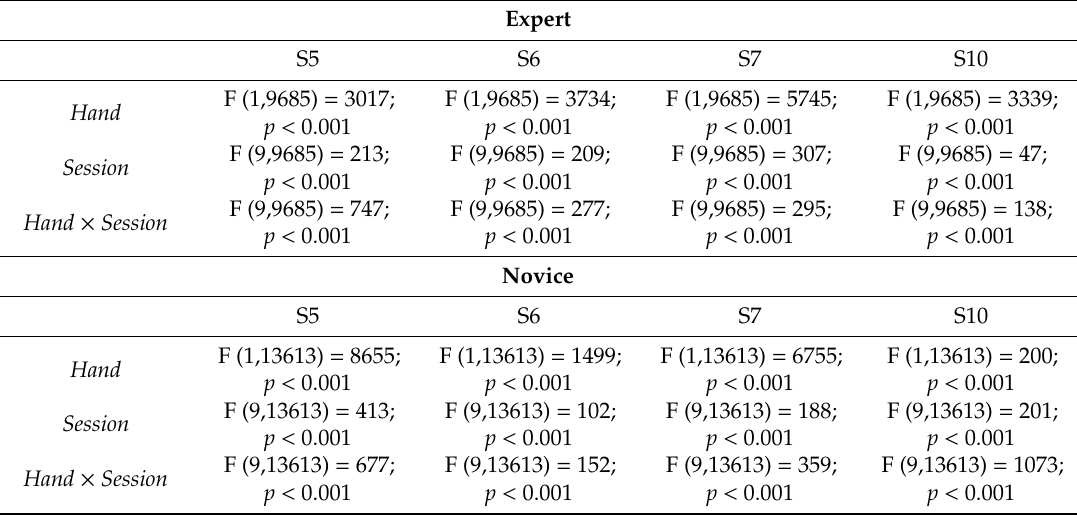
Table 2. F-statistics and probability limits relative to the e ff ects of the Hand and Session factors and their interactions from the two-way analysis of variance for each subject and